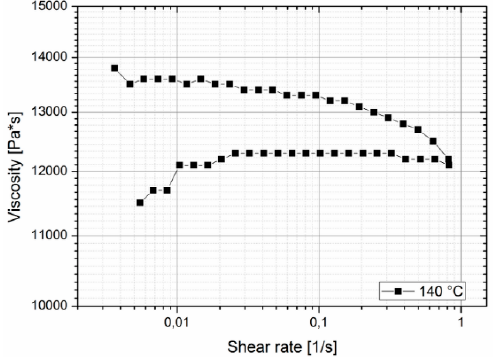
Figure 4. Shear rate vs. viscosity diagram showing the thixotropic behavior of Purasorb PDLG 5010.